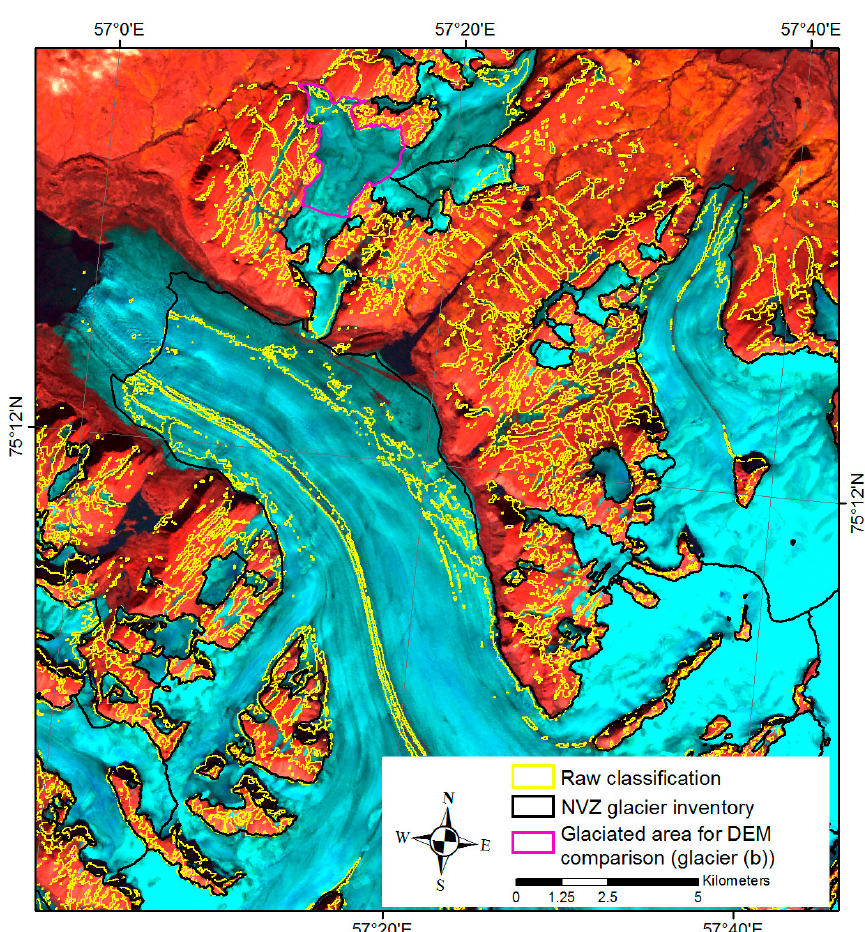
Figure 2. Raw glacier mapping from 2015 (yellow outlines) overlaid with a Landsat imagery from 1998 (band composition: SWIR, NIR, RED) used for glacier mapping due to better snow conditions. The glacier with magenta outlines was used for DEM comparison over glacierized terrain.